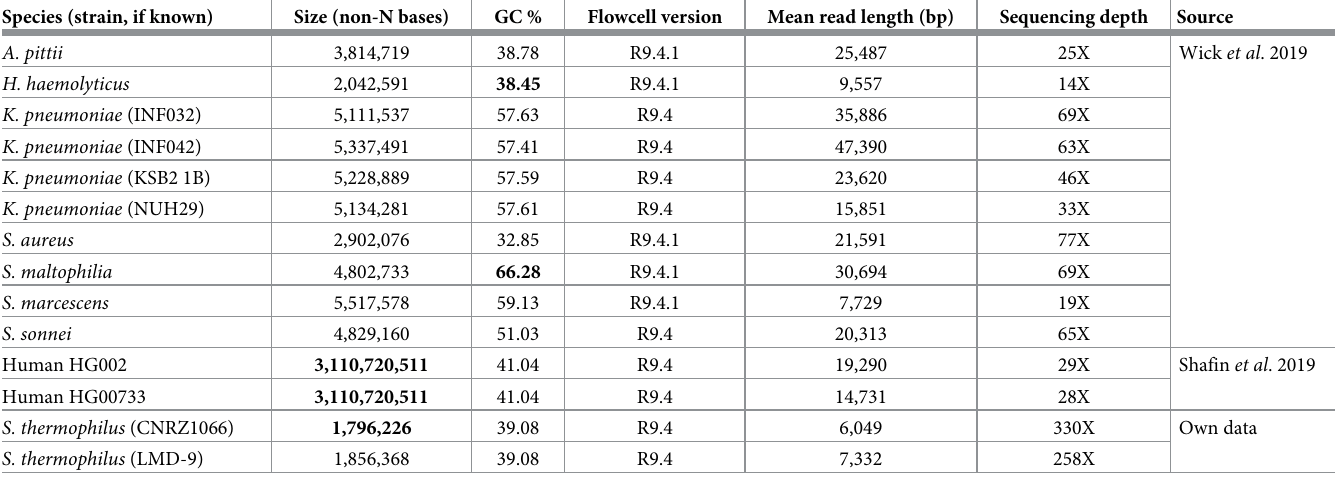
Table 1. List of studied